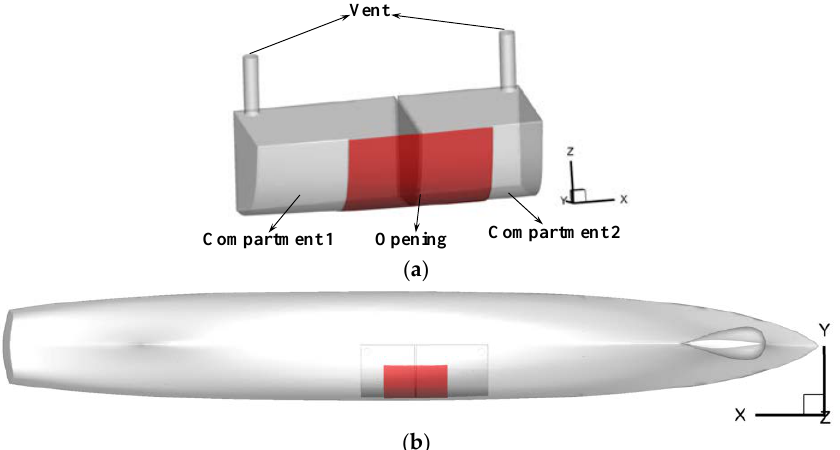
Figure 2. Model of frigate with damaged compartments for asymmetric flooding: ( a ) Compartments ( b ) Ship. Table 1. Main particulars of DTMB-5415.